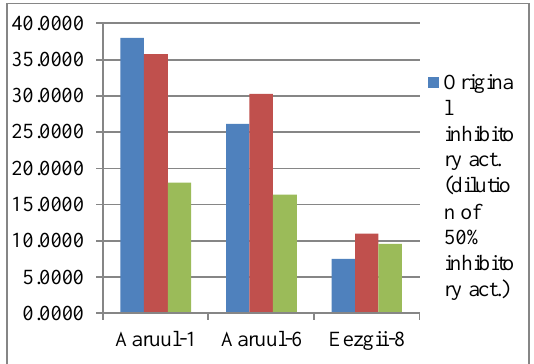
Fig.3. The ACE inhibitory activity between theoriginal and the treatments (relative ACE inhibitory index=50% inhibitory